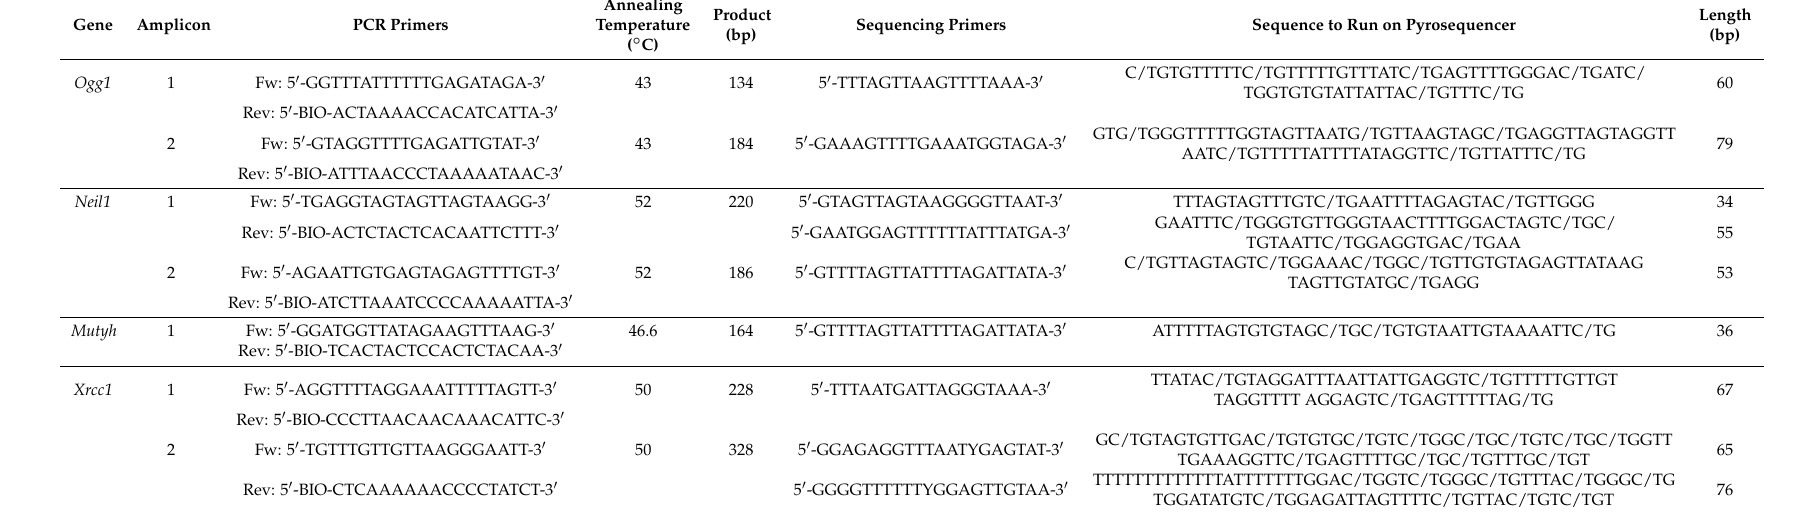
Table 1. Overview of primers and sequences to run pyrosequencing to study gene-specific